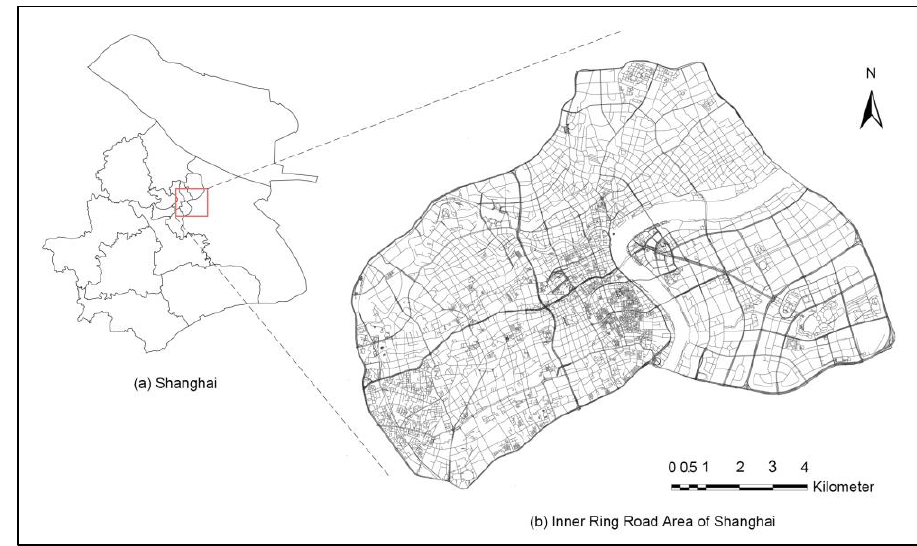
Figure 1. Study area: areas within Shanghai’s Inner Ring Road .